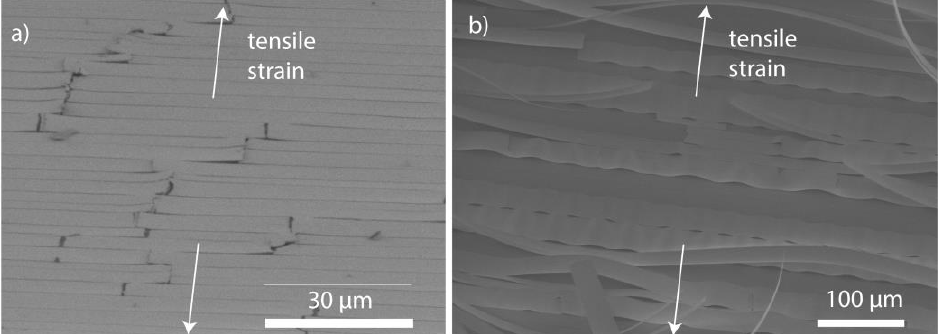
Figure 4. SEM overview of the cracked and buckled surfaces on the PET substrates after the tensile testing up to 12%. ( a ) ZnO sample (from 70° tilt angle) and ( b ) Al 2 O 3 sample (from a 45° tilt angle).